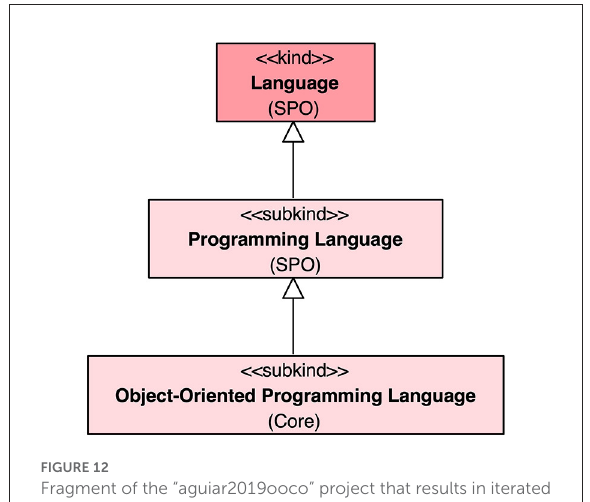
FIGURE12 Fragment of the “aguiar2019ooco” project that results in iterated lifting.